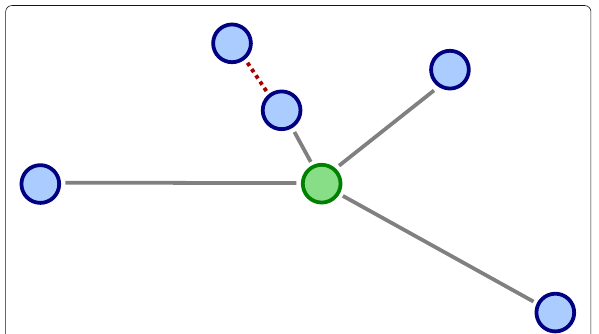
Fig. 6 Topology with virtual DTN node (green) representing the backbone